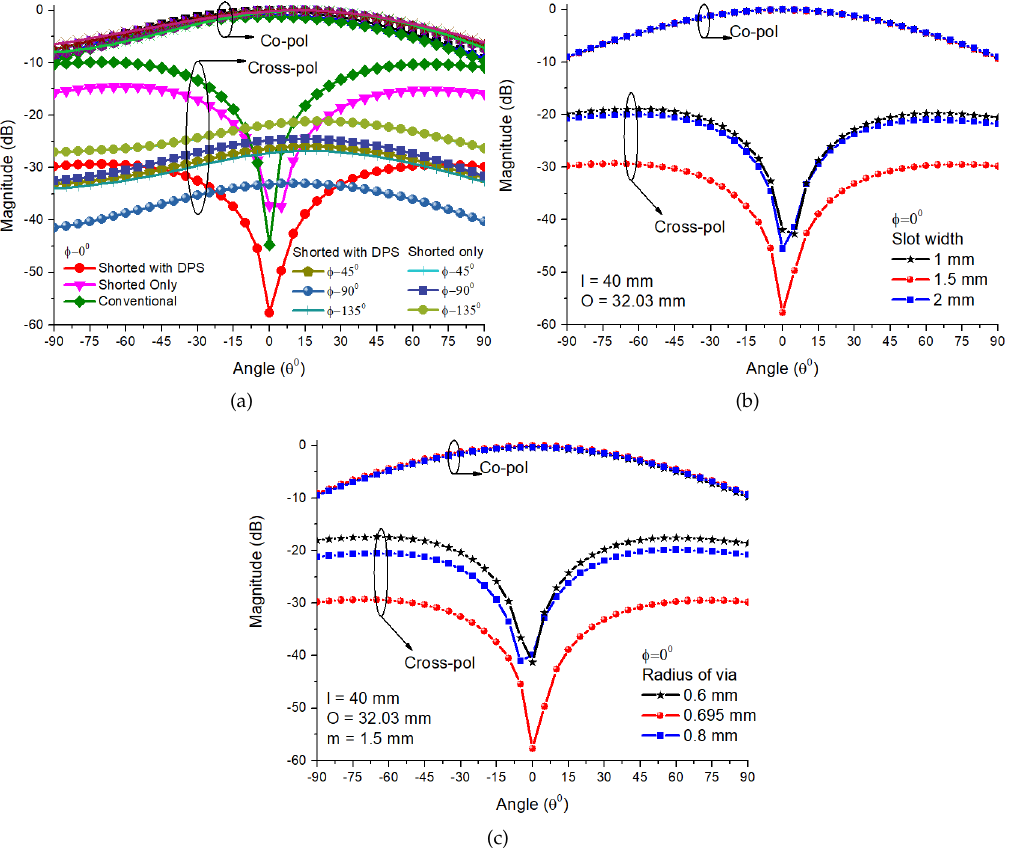
Figure 5. Parametric analysis ( a ) Co-cross-polarization isolation of all three iterations, conventional at 2.1 GHz, shorted and shorted with defected patch structure (DPS) at 2.2 GHz (impedance matching was disturbed due to the shorting in the second iteration); ( b ) Effect of slot-width on the cross-polarization; ( c ) Effect of via-radius on the